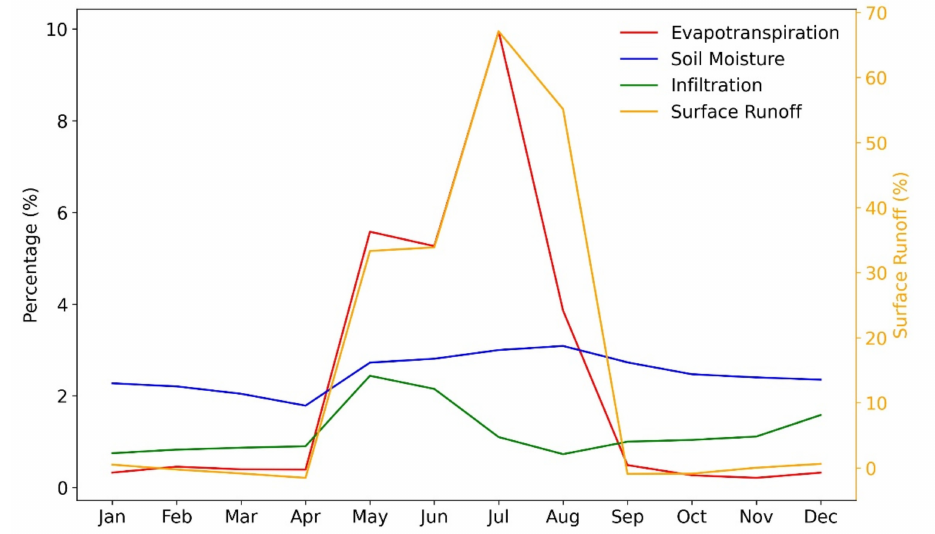
Figure 11. Long-term (1982–2008) seasonal hydrological processes analysis of U.S. Northern High Plains for irrigation scenario relative to no-irrigation